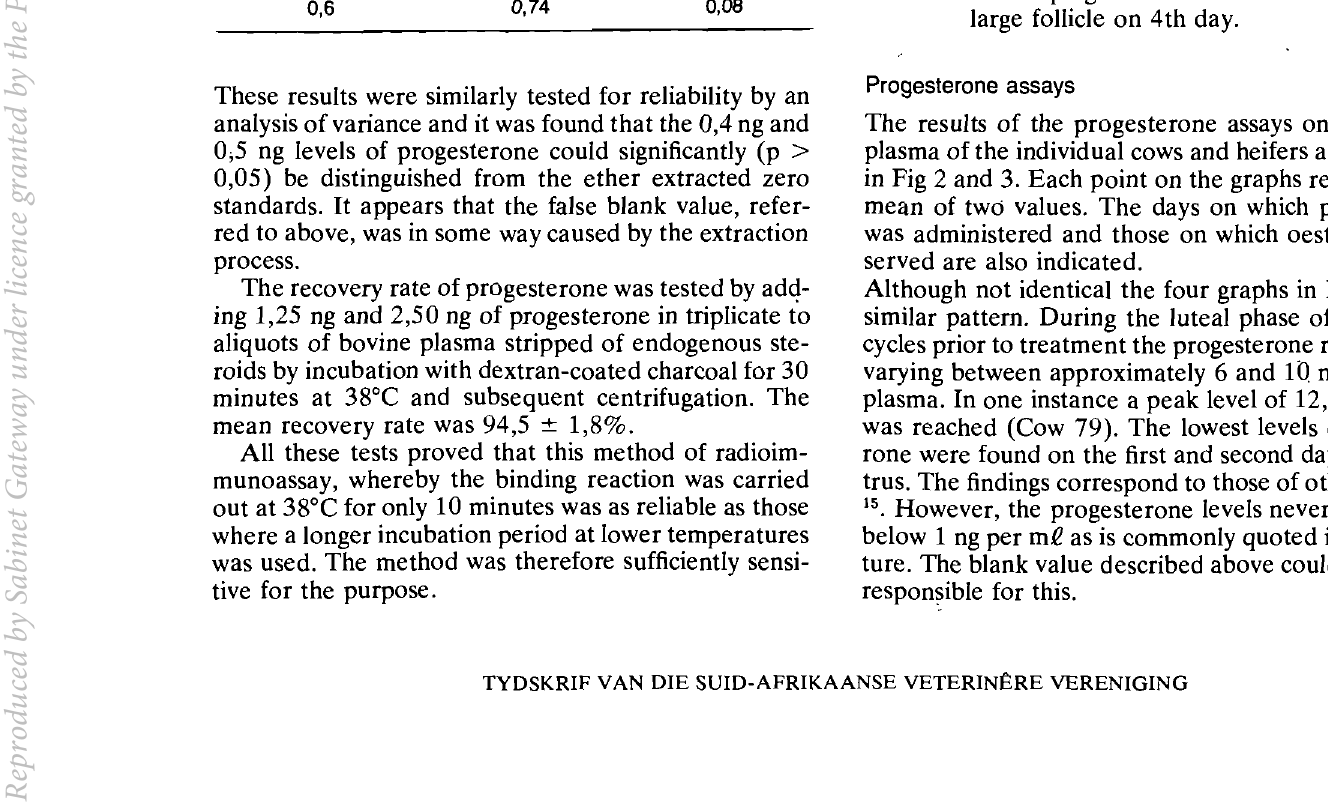
Cow 5: Developing follicle on left ovary on the 2nd, 3rd and 4th days after the last progesterone injection. Right ovary small. Cow 8: Both ovaries large, bilateral salpyngitis, de veloping follicle on right ovary on 4th day after the last progesterone injection. Cow 11: Corpus luteum on right ovary on 2nd, 3rd and 4th days after last progesterone injec tioft. Cow 79: Developing follicle' on 2nd and 3rd days and large follicle on 4th